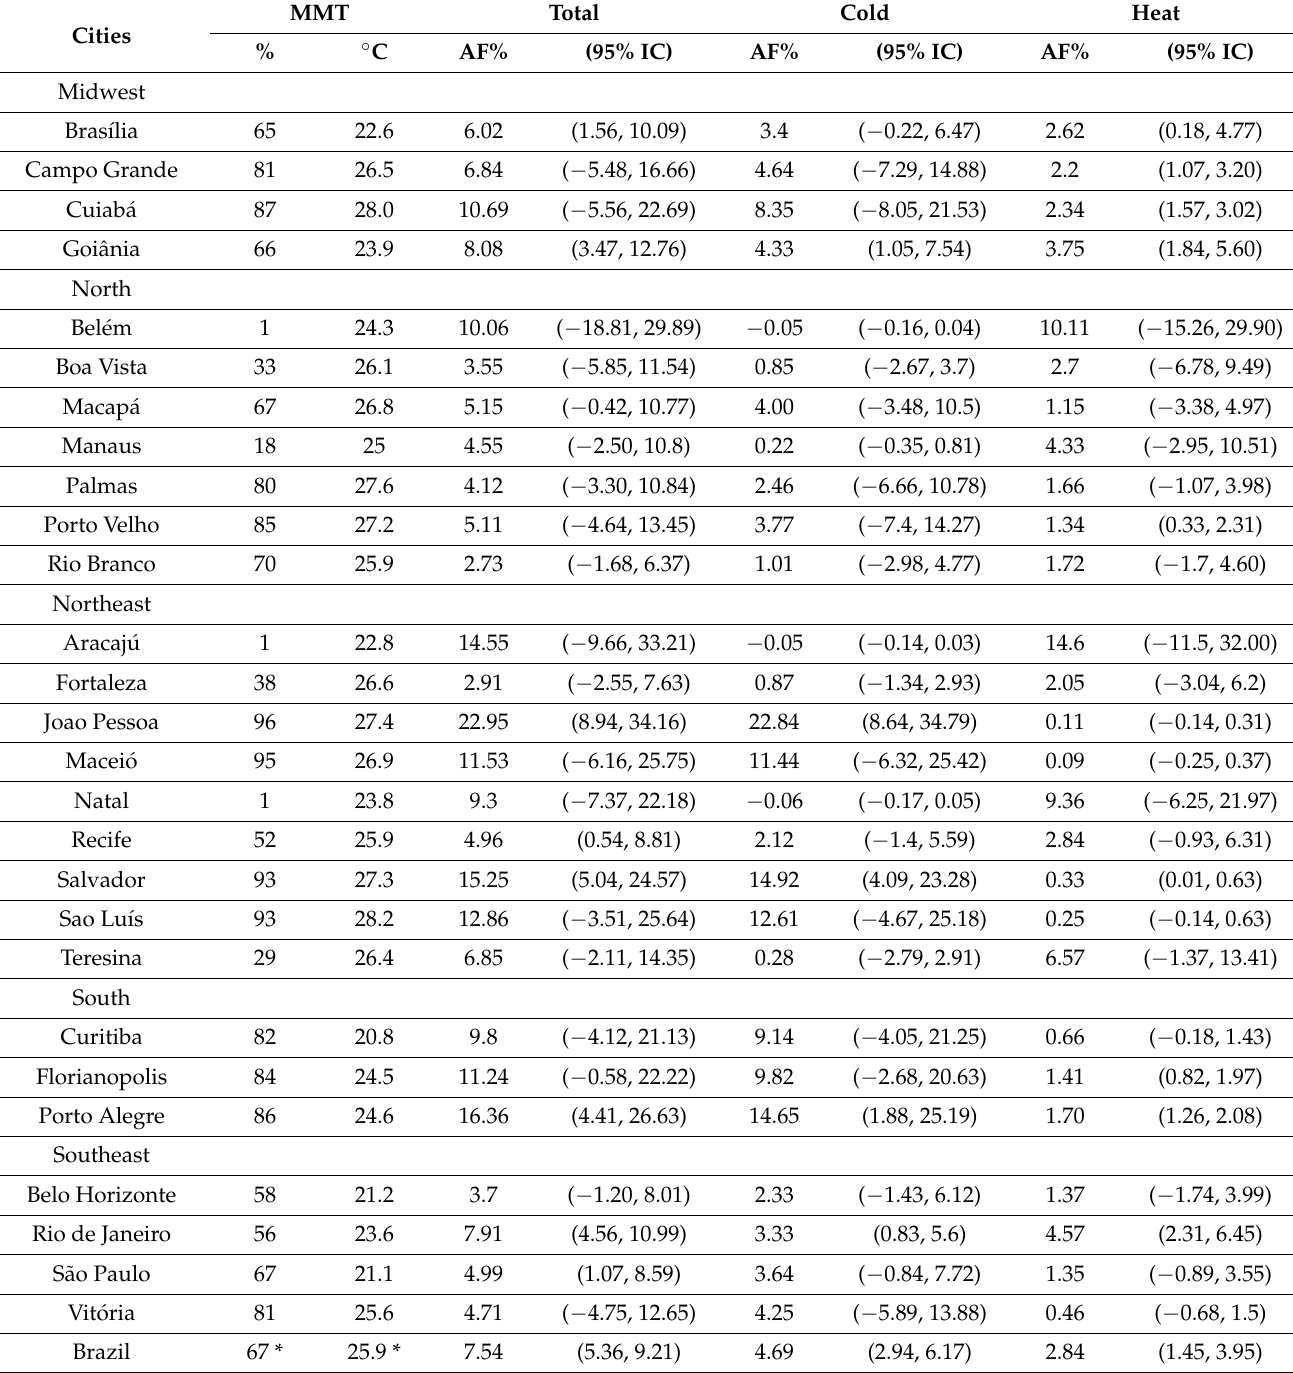
Table 2. Attributable fraction (AF) of mortality (%) and minimum mortality temperature (MMT) by capital cities and the entire Brazil, 2000 to